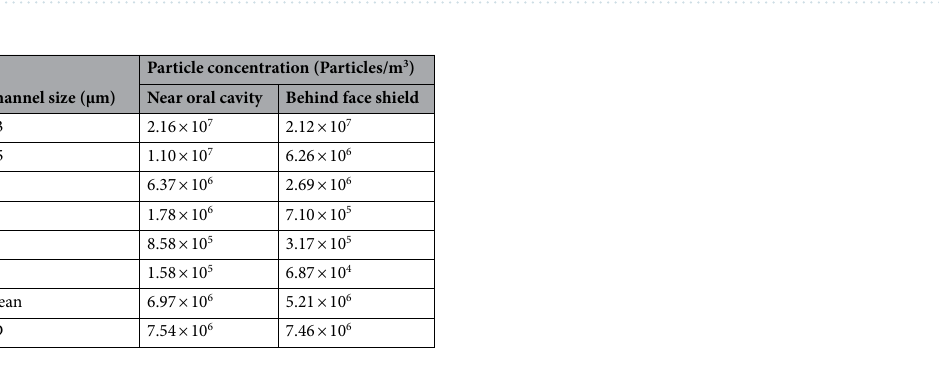
Table 2. Average particle concentration (particles/m 3 ) collected across all trials at each channel size using the optical particle counters near the oral cavity and behind the face